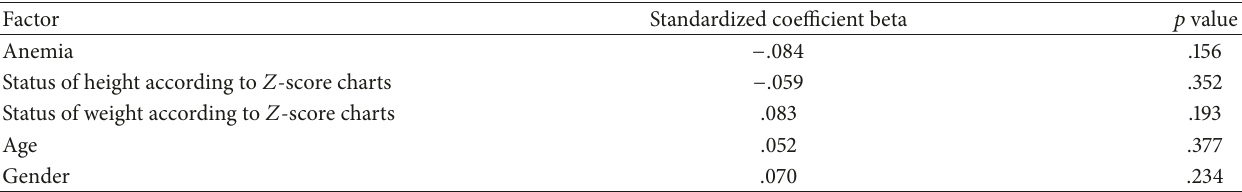
Table 6: Linear regression Model 3. Ferritin as dependent variable and anemia, status of height, status of weight, age, and gender as independent